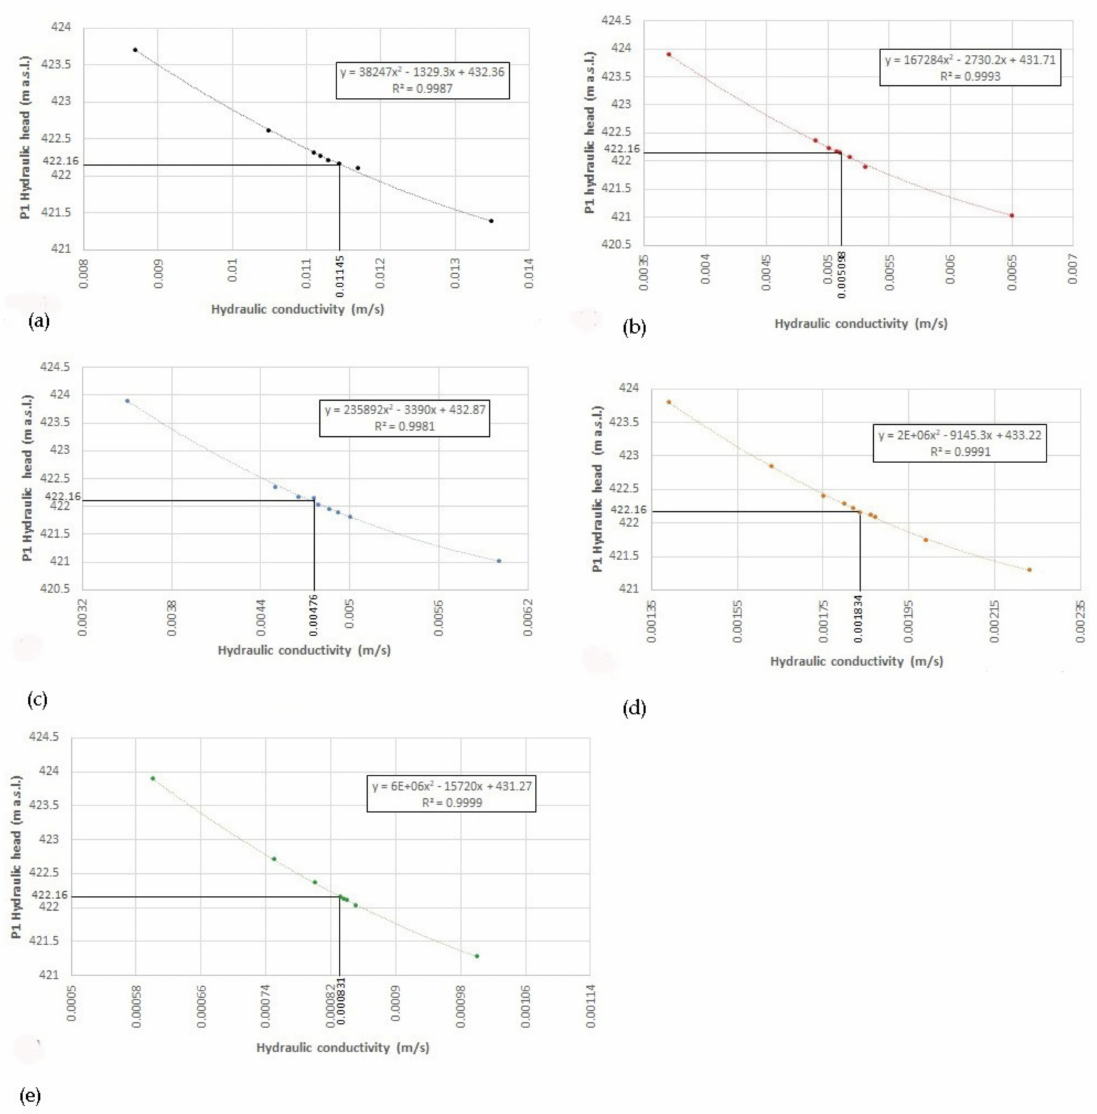
Figure 8. The simulated hydraulic head in the P1 borehole, using di ff erent values of the hydraulic conductivity, which was found based on the mean hydraulic head observed in the P1 borehole (422.16 m) and di ff erent values of TSZ: ( a ) 100 m, ( b ) 200 m, ( c ) 500 m, ( d ) 1000 m and ( e ) 2000